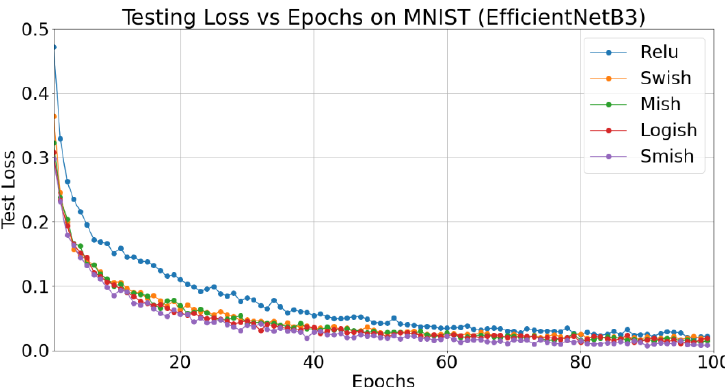
Figure 12. Loss vs. epochs in EfficientNetB3 achieved via the five activation functions on Mnist.